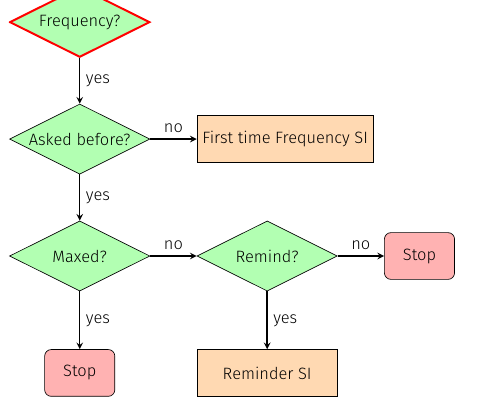
Figure 5. Data type.